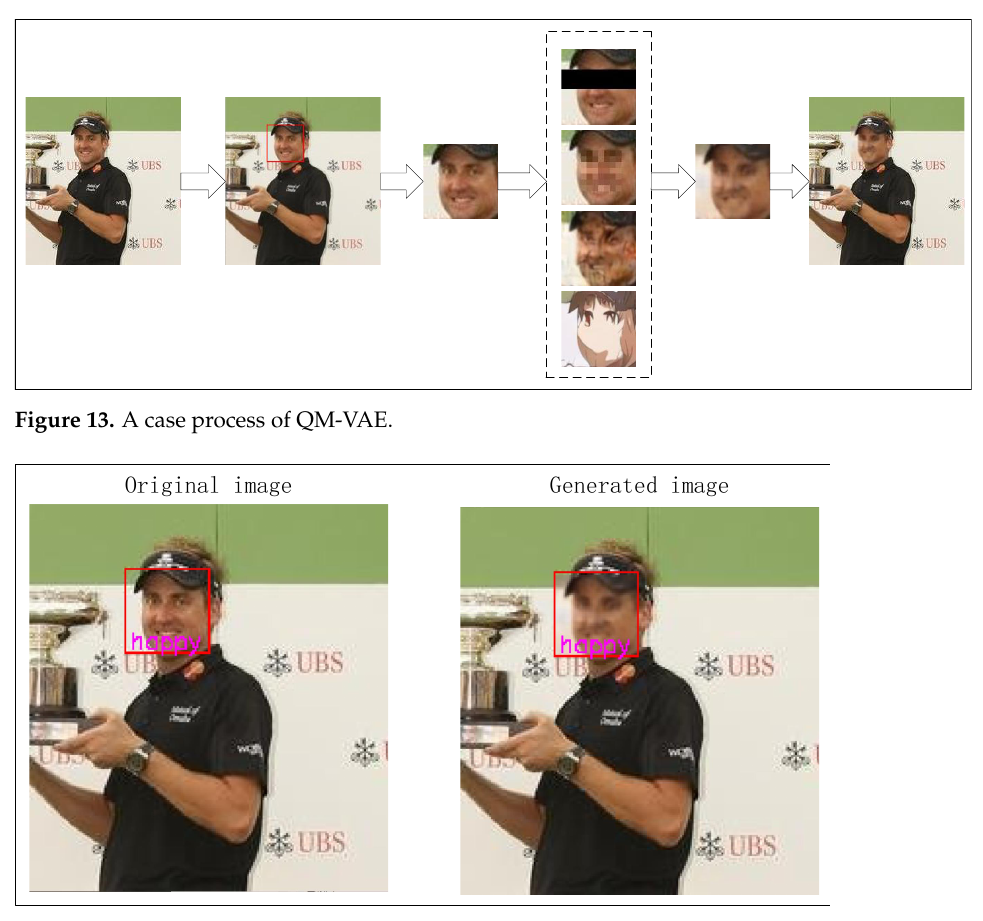
Figure 14. Image utility